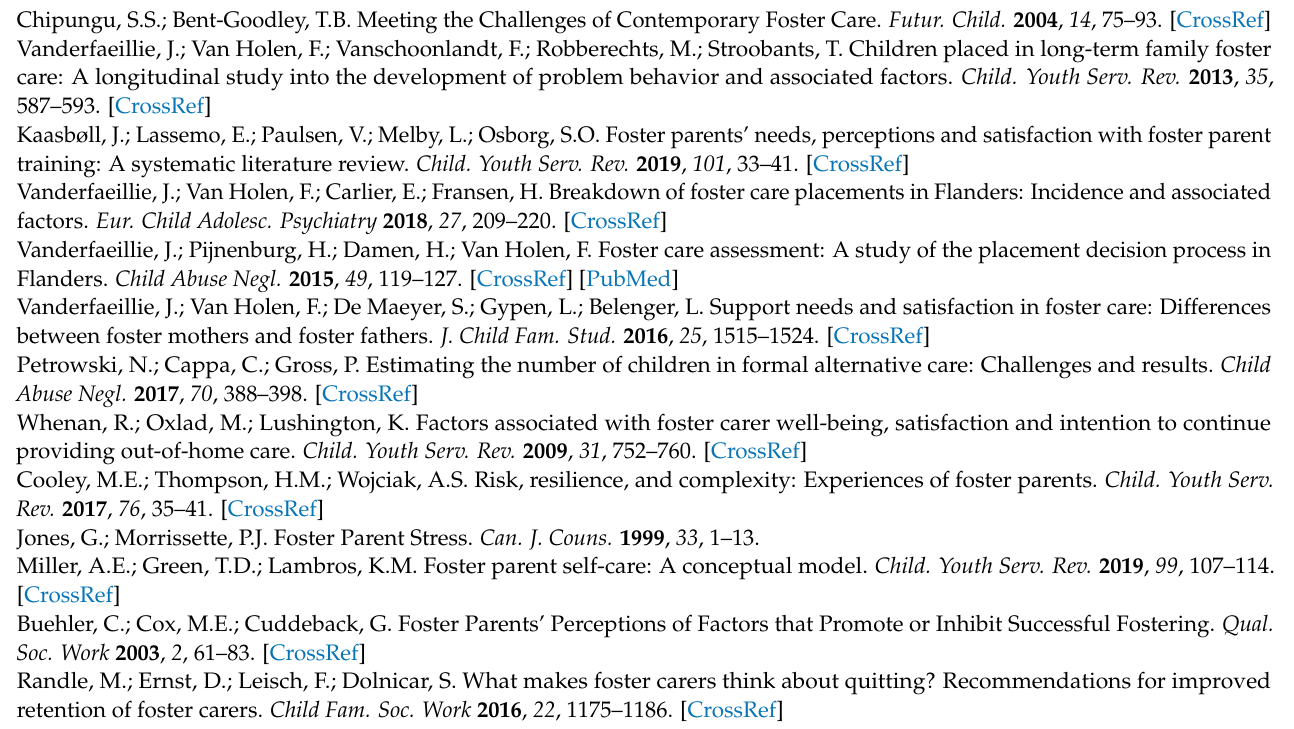
Table S4: Checklist for case-series studies; Table S5: Checklist for case-control studies. Funding: This research received no external